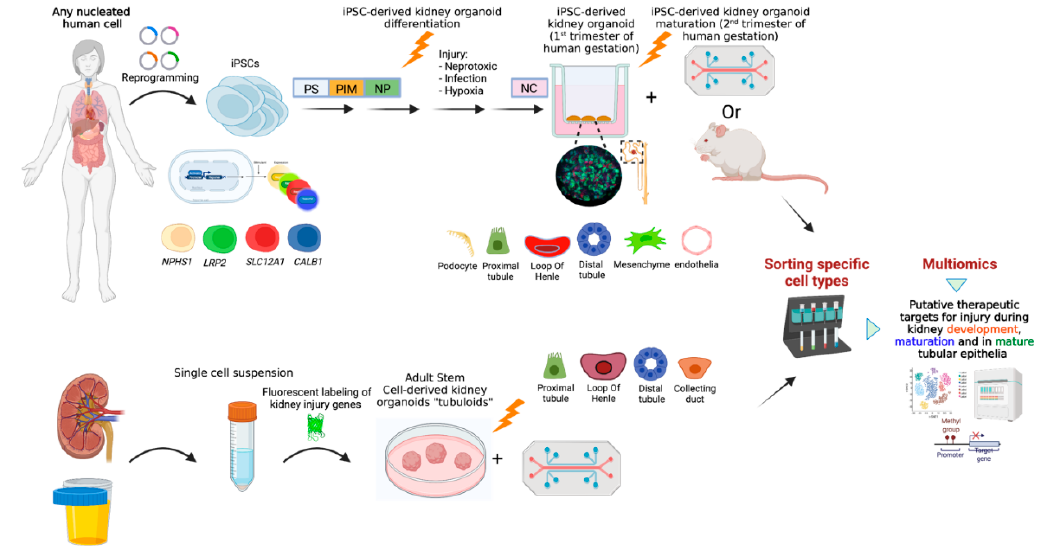
Figure 1. Kidney organoids as a useful tool for uncovering pathomechanisms underlying different types of Acute Kidney Injury and unveiling putative personalized therapeutic targets. Induced pluripotent stem cells (iPSCs) can be reprogrammed from any somatic nucleated cell. These iPSCs can undergo sequential differentiation toward kidney organoids. The use of CRISPR/Cas9 gene-edited reporter iPSC lines in which a fluorescent marker is inserted under the promotor of a specific kidney-cell lineage gene (i.e., NPHS1 for podocytes, LRP2 for PT, SLC12A1 for LOH, CALB1 for DT, etc.), enables a lineage tracing system during kidney organoid differentiation, maturation and following injury. Maturation of kidney organoids equivalent to the second trimester of human gestation can be achieved via transplantation of kidney organoids under the renal capsule of immunodeficient mice or via growing them on a chip under continuous flow (upper panel); Organoids composed of the different epithelial cells that comprise the kidney tubules (also known as ‘tubuloids’) can be generated either from mature kidney tissue or from urine (lower panel). Following a processing procedure, a single cell suspension is achieved. Cells are subsequently aggregated and cultured in specific conditions. Tubuloids can grow on scaffolds (‘chip’) that enable delivery of nephrotoxins. Epithelial tubuloids are amenable to genetic editing. Fluorescent labeling of kidney injury genes enables analysis of response to injury at a cell-specific manner. Fluorescent based cell sorting of post-injury kidney organoids and tubuloids followed by genomic, transcriptomic, proteomic, metabolomic and epigenomic analyses may unveil unique effects of different types of injuries on specific kidney cell types, signaling pathways and molecular components and bring forward putative AKI-pathomechanism-driven therapeutic targets. PT, Proximal Tubules; LOH, Loop of Henle; DT, Distal Tubules; PS, Primitive Streak; PIM, Posterior Intermediate Mesoderm; NP, Nephron Progenitors; NC, Nephron